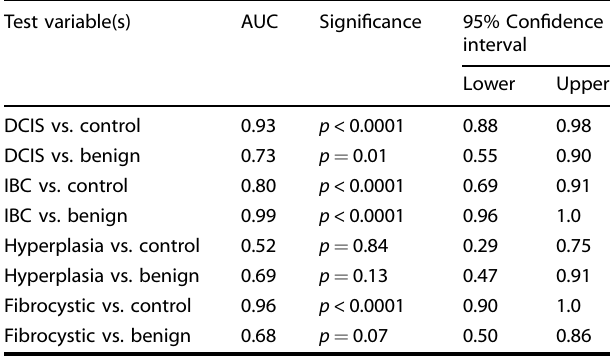
Table 3. Autoantibodies against the antigens detected women with breast tumors as compared to control women or women with benign